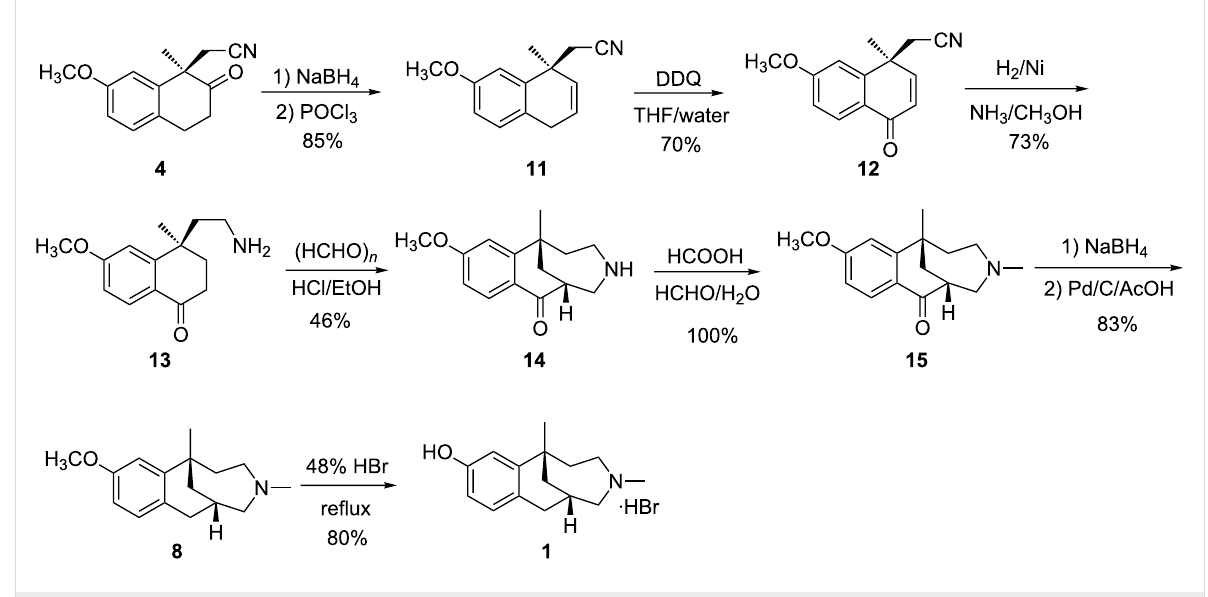
Scheme 4: The second strategy for the asymmetric synthesis of 1 .